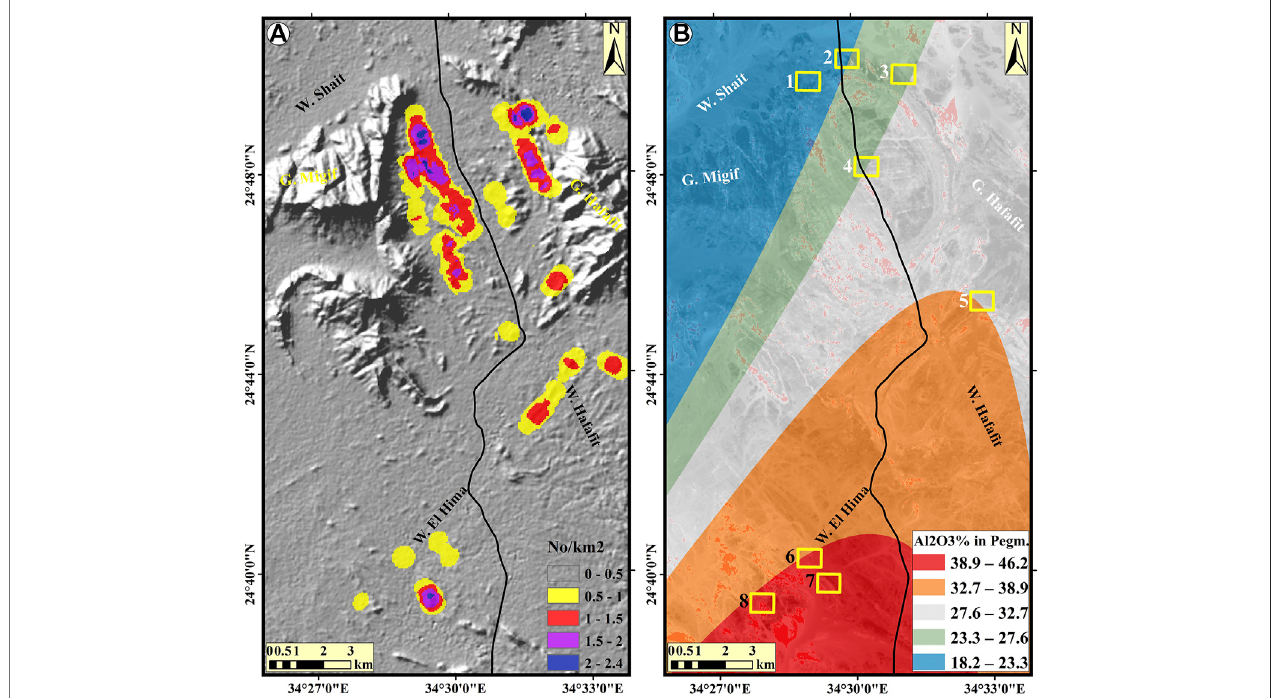
FIGURE 11 | (A) Density map of the extracted pegmatite veins and lenses (Note: this map excluded the white pegmatite body in the southwestern part ofthe area, Figure 1 and (B) Geospatial distribution of Al 2 O 3 content of the pegmatites veins and lenses based on the chemical analysis of the collected samples drapped over the potential abundance of pegmatites produced by the remotely sensed data.